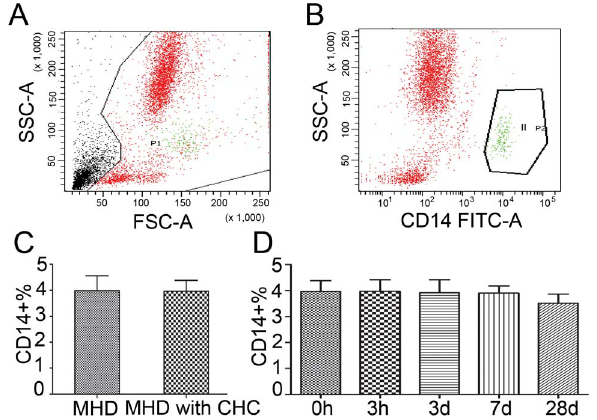
Figure 1. Viral dynamics of HCV RNA during the DFPP in MHD patients with CHC. A. The titers of HCV RNA before and after the DFPP. B. The titers of HCV RNA during 28 days after DFPP. The Y axis indicates the log HCV RNA. The X axis indicates the time course of the therapy. 0 h means before the DFPP, 3 h means after the DFPP, 28 d means 28 days after the DFPP. PLOS ONE |